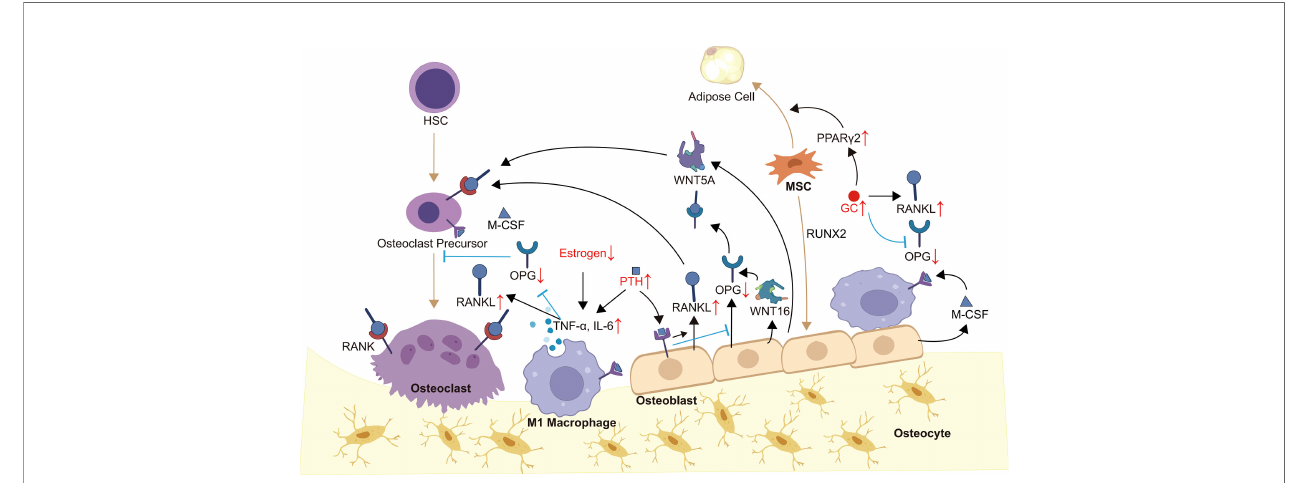
FIGURE 1 | OB-OC-M F axis in osteoporosis. Members of the OB-OC-M F axis maintain the axis ’ s equilibrium through intricate communication, which is mostly shown in appropriate levels of cytokines such as RANK, RNAKL, OPG, M-CSF, WNT5A, WNT16, and TNF- a . Endogenous or exogenous factors, such as evident in fl ammatory responses and aberrant hormone levels, might alter the levels of various cytokines, causing an imbalance of the OB-OC-M F axis and, ultimately, the occurrence and progression of osteoporosis. Brown arrows indicate the direction of cell differentiation, and small red arrows indicate abnormal changes in hormone or cytokine levels.